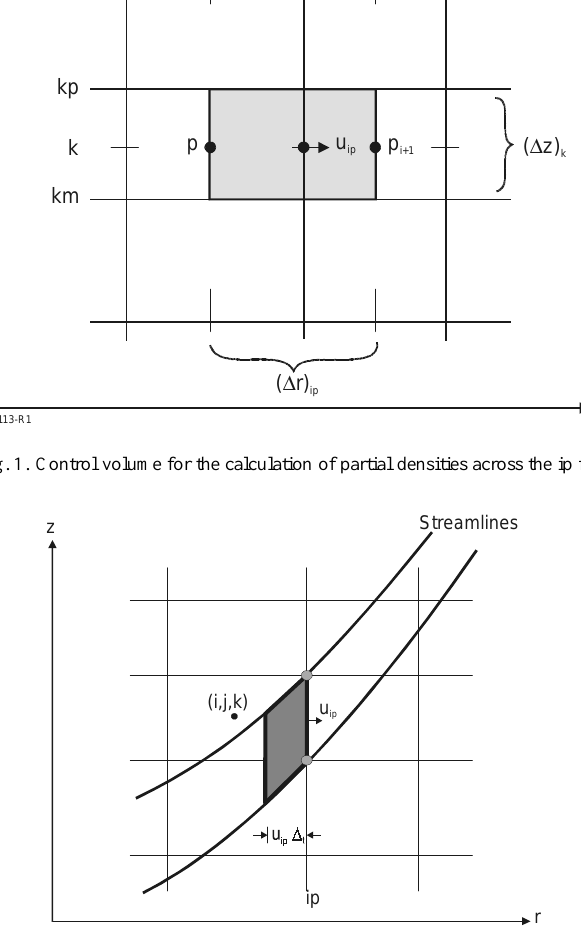
Fig. 2. Control volume for the calculation of mass flux across the ip